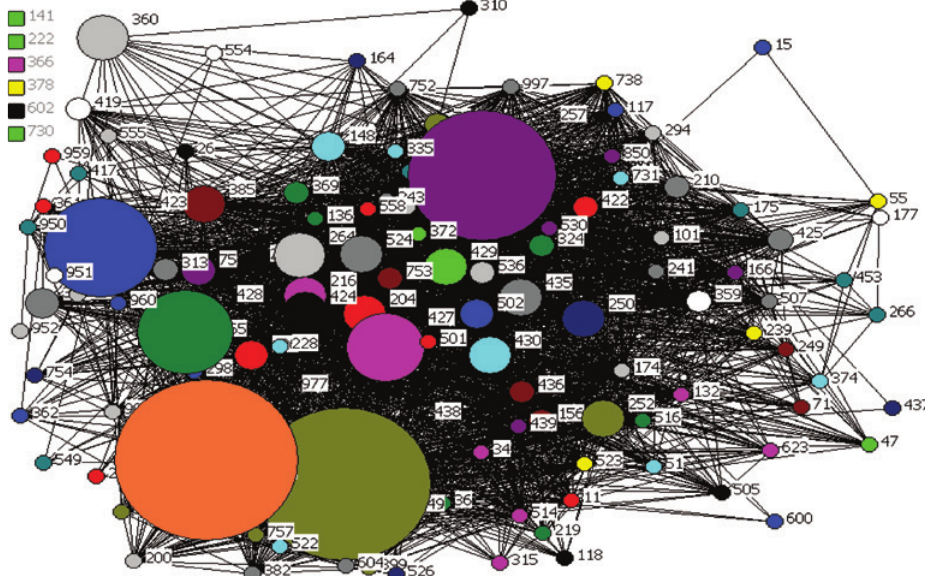
Figure 4: The classification number network in 2006 ~ 2010.